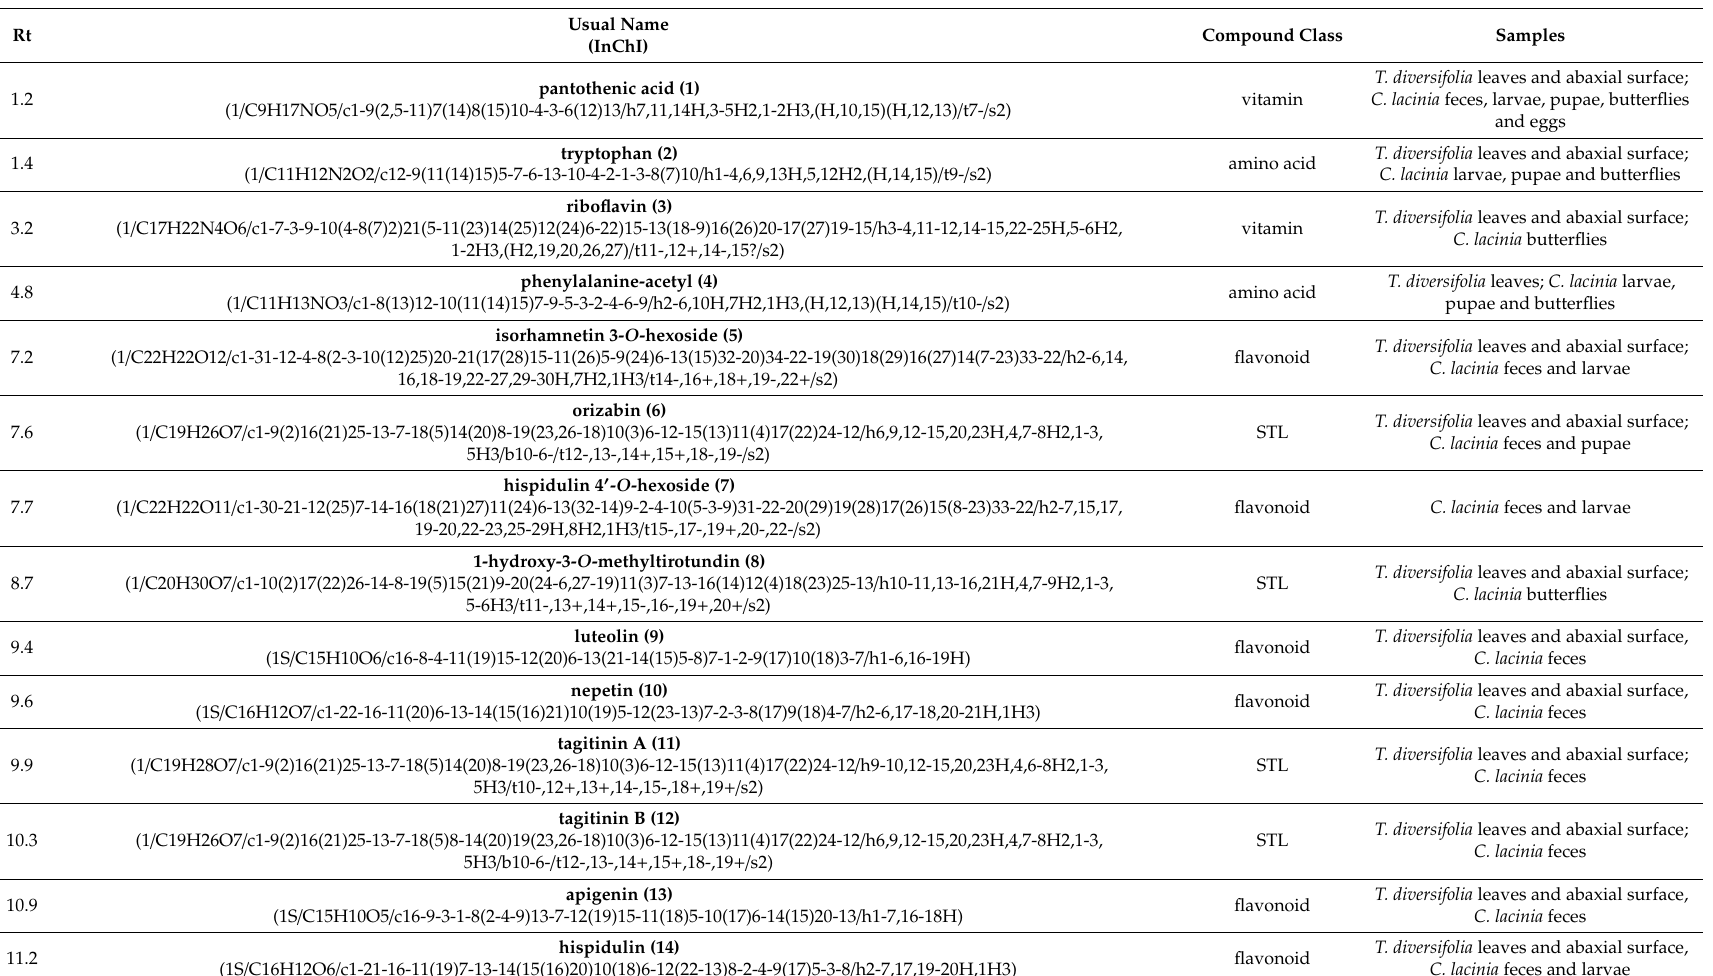
Table 2. Putatively annotated compounds in T. diversifolia and C. lacinia